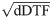
Effective coupling in the slow gamma band.Time course of dDTF value in the slow gamma (20–60 Hz) band, averaged over WT (A) and APP/PS1 (B) mice. Every box shows mean values of dDTF in the slow gamma frequency interval in consecutive time windows. Significant modification of the coupling value compared to the value of the coupling in the first bin is indicated by stars (Wilcoxon’s test with Bonferroni correction). Other abbreviations as in Fig 2. * p < 0.05, ** p < 0.01, *** p < 0.001. Time bin size is 70 ms.